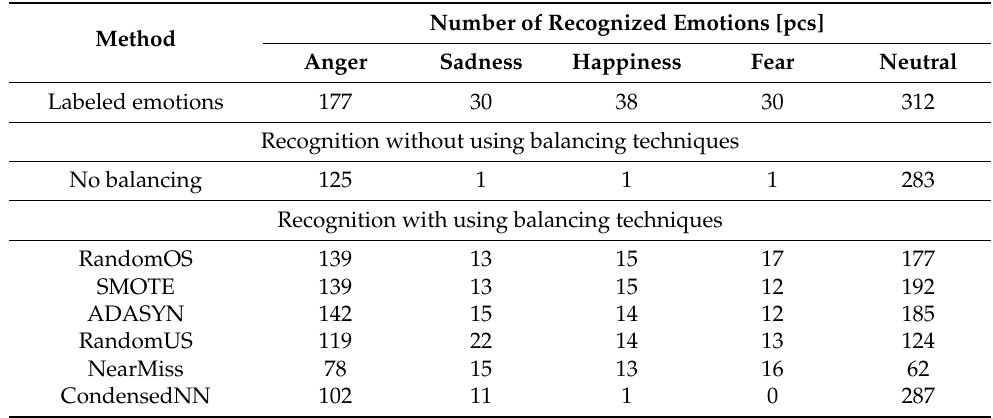
Table 4. The impact of balancing methods on the number of recognized emotions for SVM